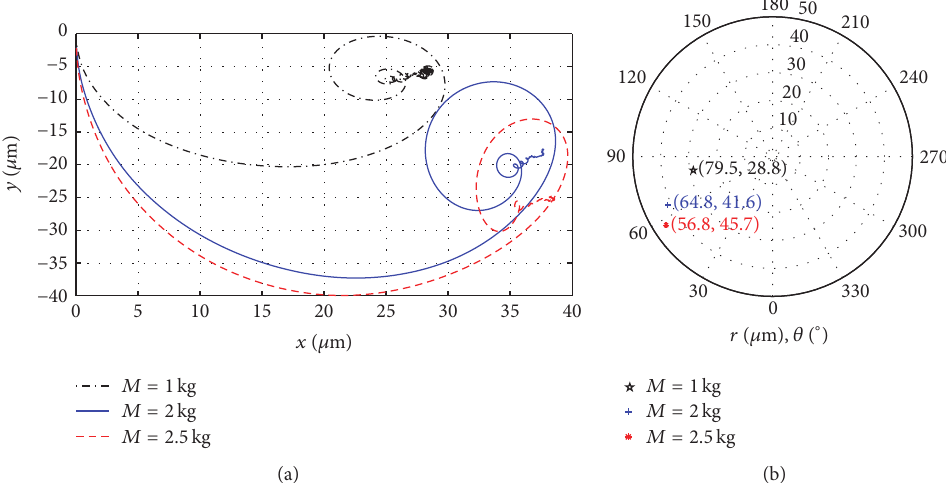
Figure 11: (a) Rotor trajectory and (b) polar coordinates of the HGGJB under different bearing capacities at the rotating speed of 10000 r/min.